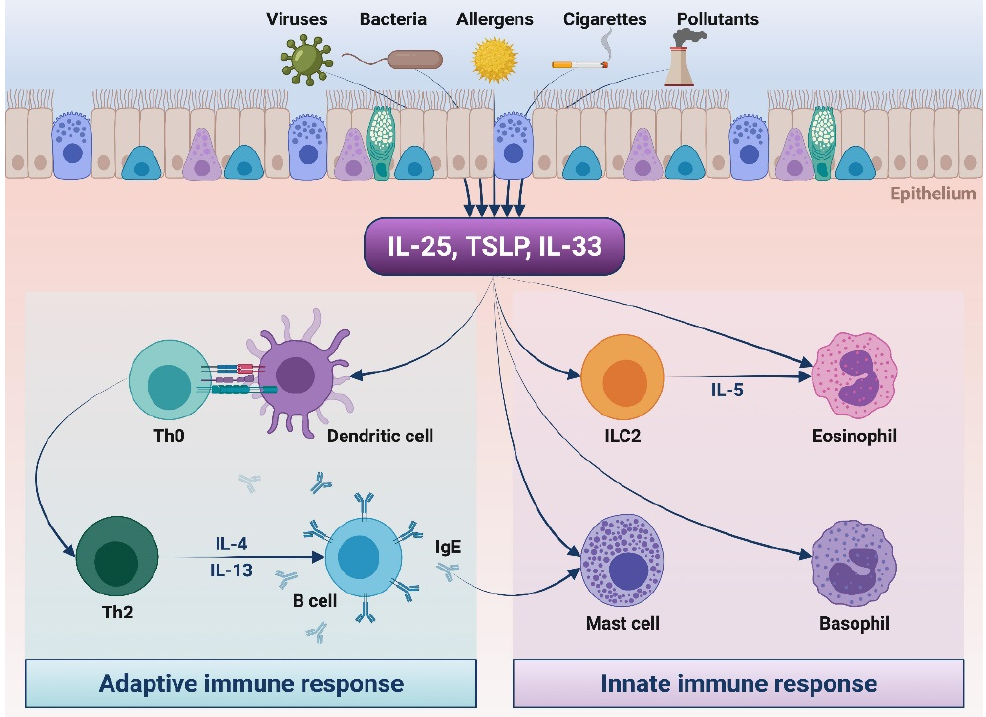
Figure 1. Pathogenic actions of alarmins in type 2 asthma. As a result of injuries caused by several noxious agents, airway epithelial cells release alarmins (TSLP, IL-33, and IL-25). These cytokines induce the activation of the adaptive immune system, thus driving dendritic cell-mediated differentiation of Th2 lymphocytes, leading to B cell-dependent production of immunoglobulins E (IgE). Alarmins also elicit innate immune responses by directly stimulating group 2 innate lymphoid cells (ILC2), eosinophils, basophils, and mast cells. Upon activation induced by alarmins, Th2 and ILC2 cells release high amounts of IL-4, IL-5, and IL-13. This original figure was created by the authors using “BioRender.com” (accessed on 8 August 2021).